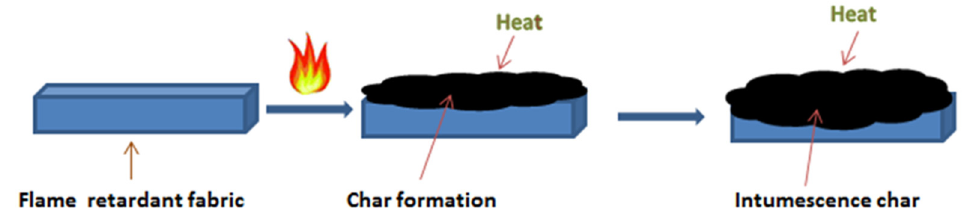
Figure 8. Mechanism of flame retardant fabric. Table 4. Comparison of flame retardancy.